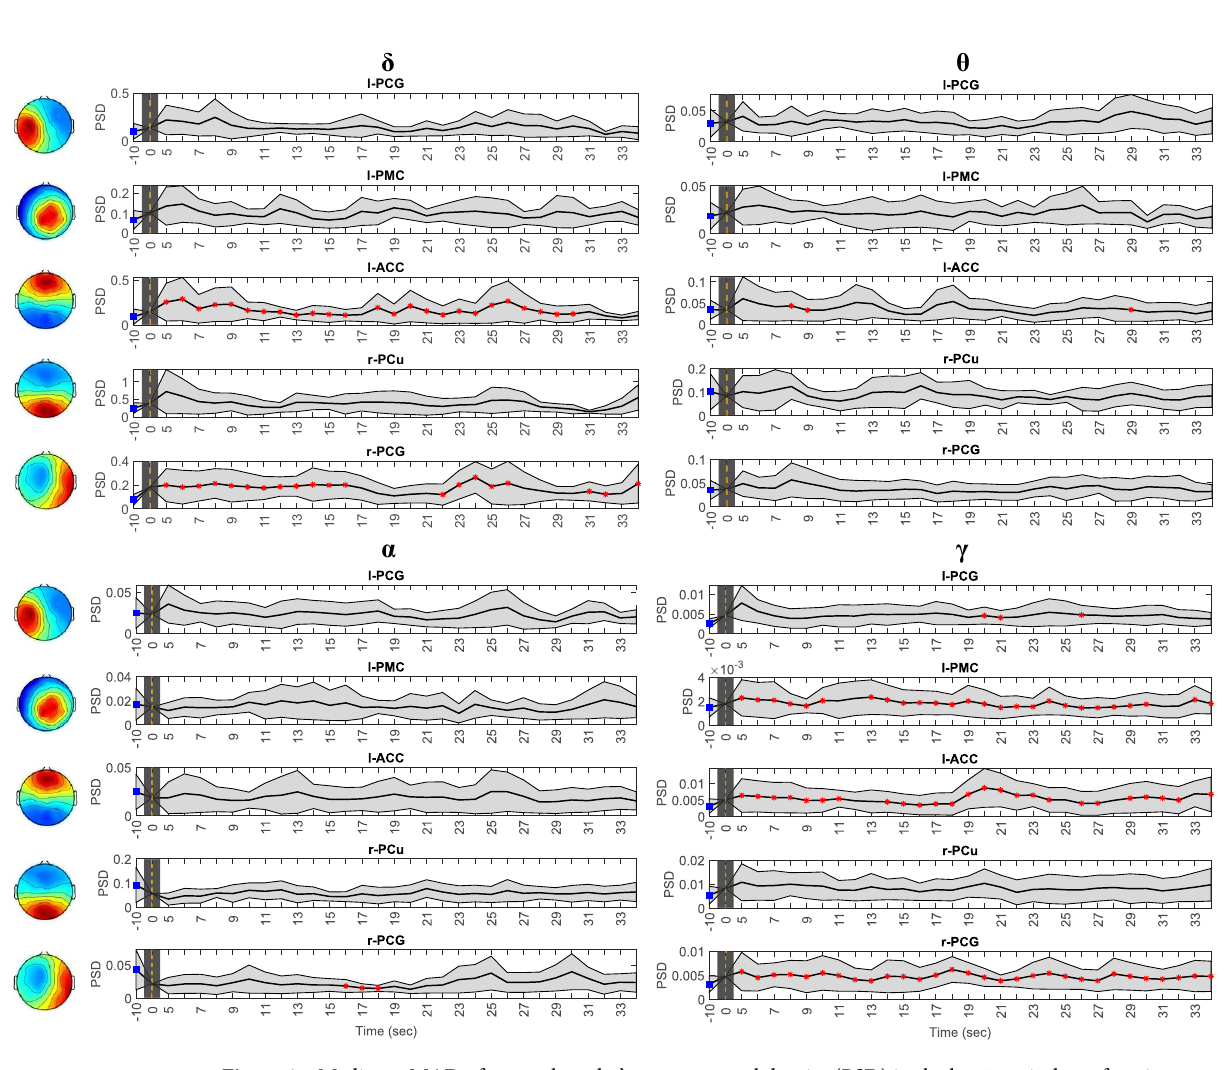
Figure 3. Median ± MAD of network nodes’ power spectral density (PSD) in the last 5 s window of resting- state (i.e., from − 10 s to − 5 s; " Blue square ") and in the first 30 s of cold pressor test (CPT) (i.e., from +5 s to +35 s), for the δ , θ , α , and γ bands. The CPT start is marked by a dashed line at 0s. Each time point represent the value of PSD evaluated within a 5 s-long window, with 1 s shift. Significant differences (" Red asterisk ") between consecutive time widows of CPT and the last 5 s of resting-state were assessed with a Wilcoxon signrank test ( p < 0.05 , FDR-corrected). We report only those frequency bands for which we observed significant